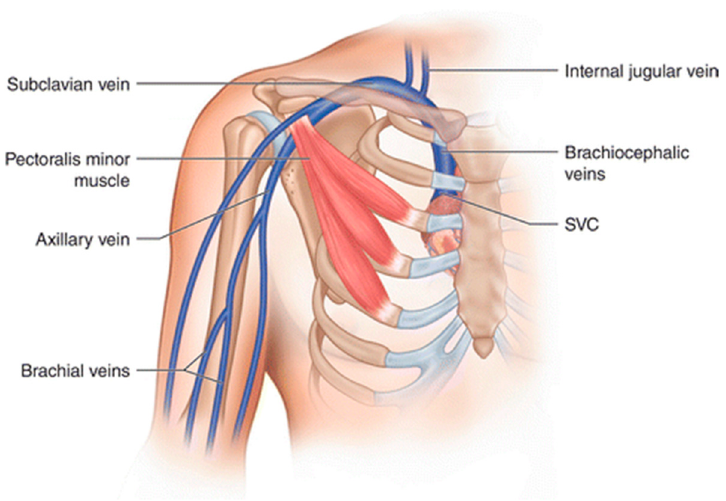
Figure 1. Anatomy of deep venous system of the upper extremity. Abbreviations: SVC, superior vena cava.